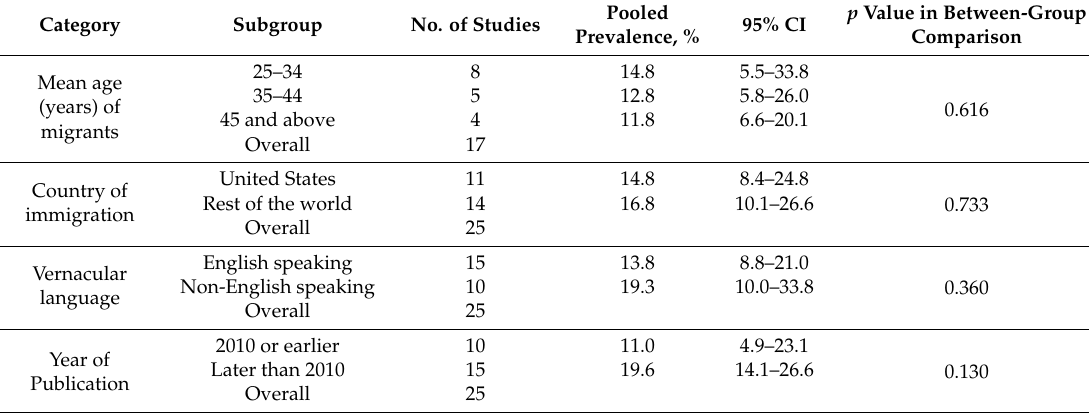
Table 2. Results for subgroup